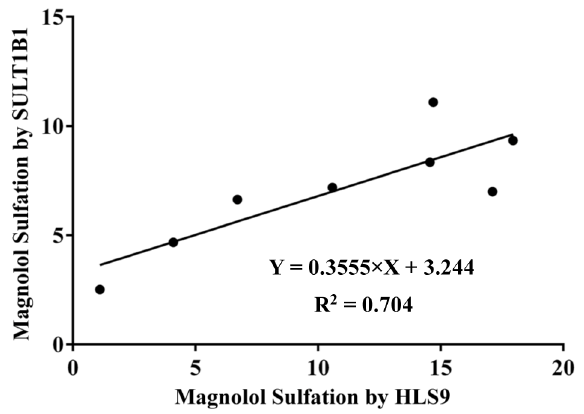
Figure 6. Correlation analysis between the sulfation activities of human liver S9 (HLS9) and